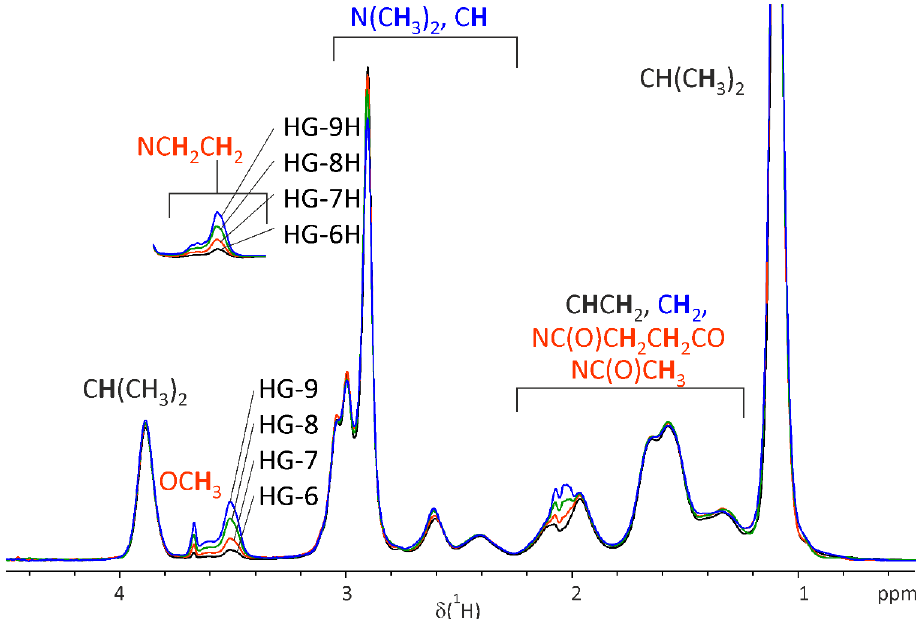
Figure 2. HR-MAS 1 H spectra of HG-6 to -9 swollen in D 2 O. The inset shows the 3.4–3.8 ppm region for the hydrolyzed hydrogels HG-6H to -9H. The signal assignments refer to DMAA (blue), NIPAAm (black) and MM (red) comonomer.